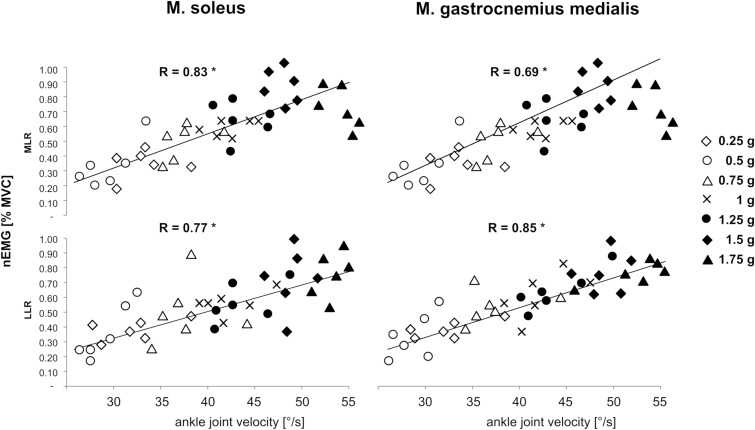
Gravity-dependent bivariate correlations and correlation coefficients among the variable angular velocity of the ankle joint (abscissa) with the normalized EMGs of M. soleus (left leg) and M. gastrocnemius medialis (right leg) in the relevant EMG phases Medium-latency response (MLR, 60–85 ms after perturbation onset) and long-latency response (LLR, 85–120 ms after perturbation onset, ordinate) during left posterior perturbation. Findings revealed that the EMG was positively correlated to ankle joint velocity (∗ indicate significant findings p < 0.05).